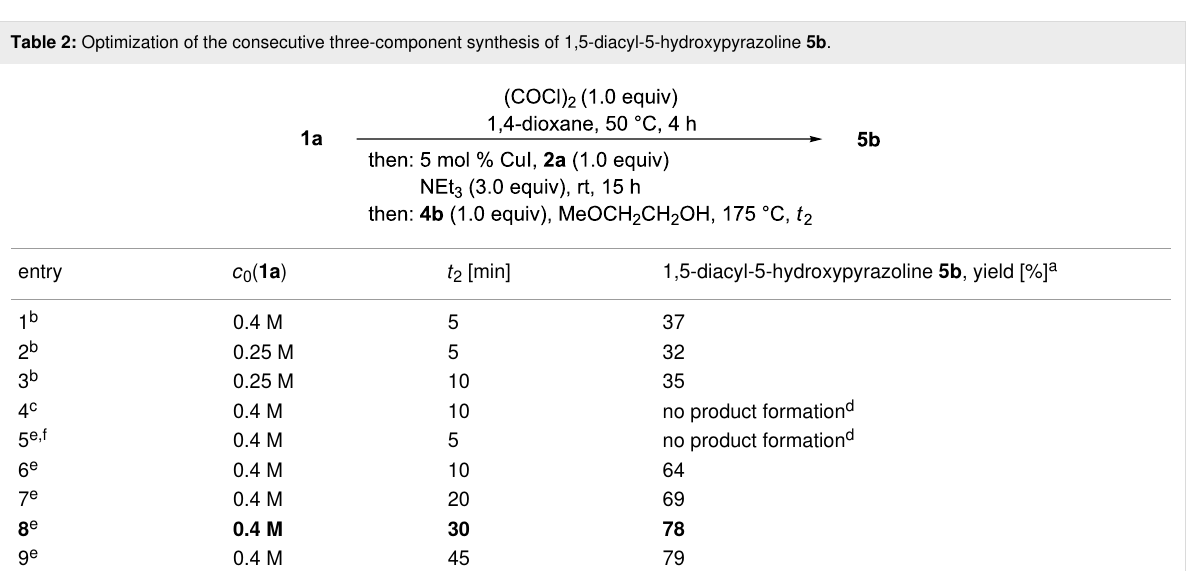
Table 2: Optimization of the consecutive three-component synthesis of 1,5-diacyl-5-hydroxypyrazoline 5b